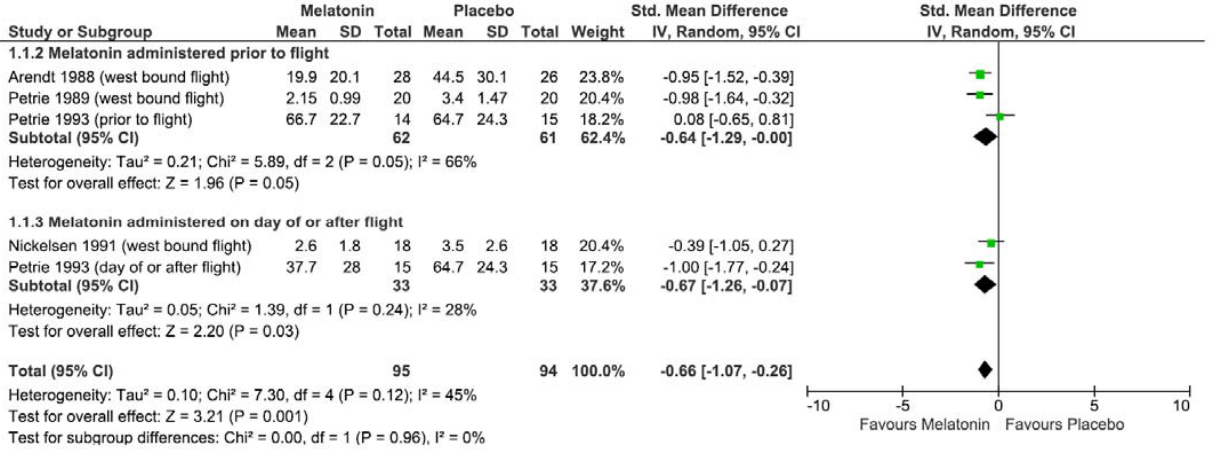
Figure 2. Forest plot of Cohen d effect size (standard mean difference) of studies examining the effect of melatonin on participant self-reported jetlag symptoms following westbound commercial air flights using a random effects model. Studies grouped by melatonin administration time of either prior to departure or at bedtime on the day of flight or after arrival. Diamond represents overall effect size, squares indicate percentage weighting of each study to overall effect size and 95% confidence intervals shown using horizontal lines.